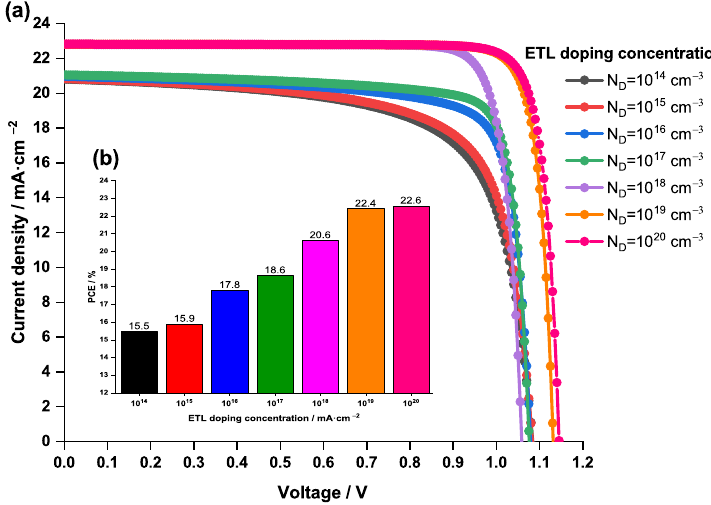
Figure 11. Effect of the doping concentration of the ETL ZnOS on ( a ) the current density—voltage characteristics of the PSC and ( b ) the